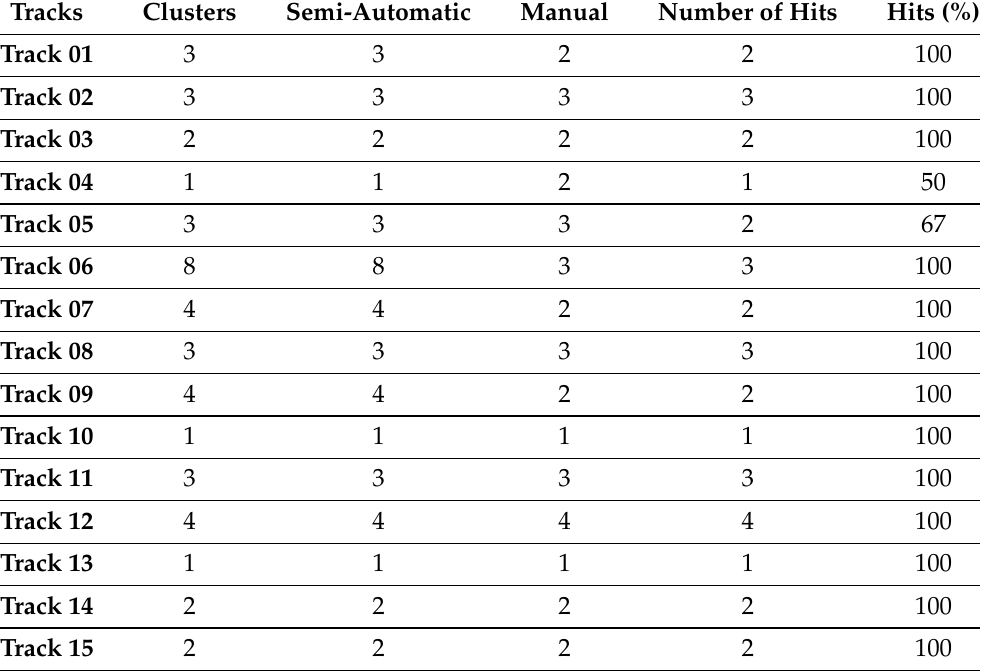
Table 2. A Comparison between the Semantic Enrichment